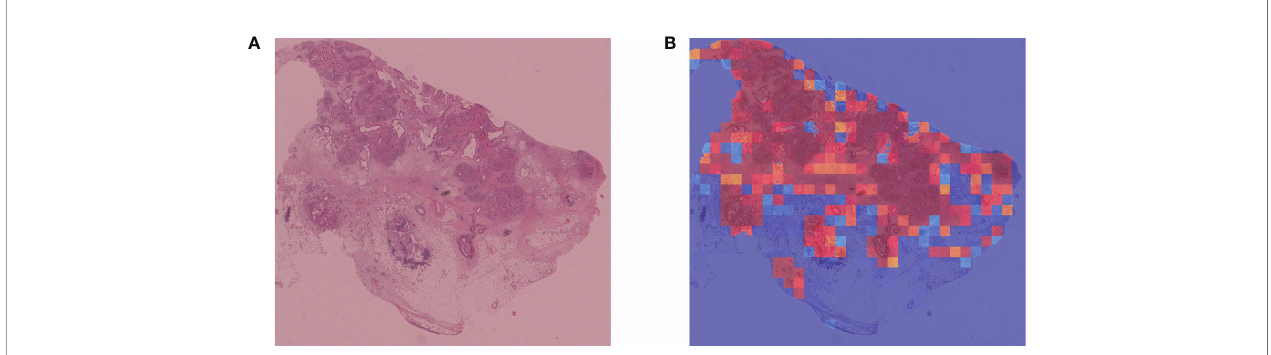
FIGURE 5 | Independent veri fi cation results. (A) Sample WSI labeled as carcinoma by TCGA. (B) Cancer probability heatmap from our WSI classi fi cation